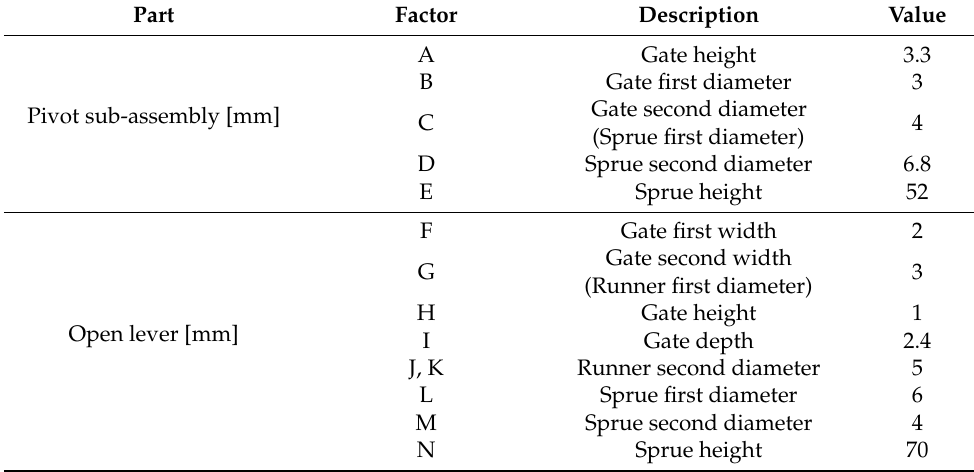
Table 4. Specification of runner